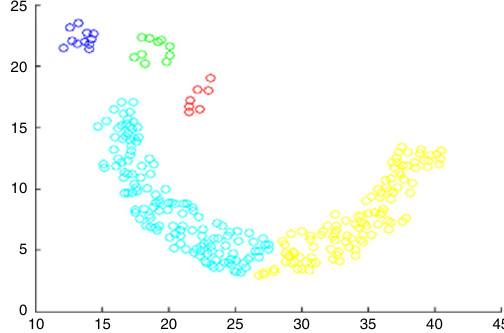
Figure 15. Result of our algorithm on “ Jain ” data